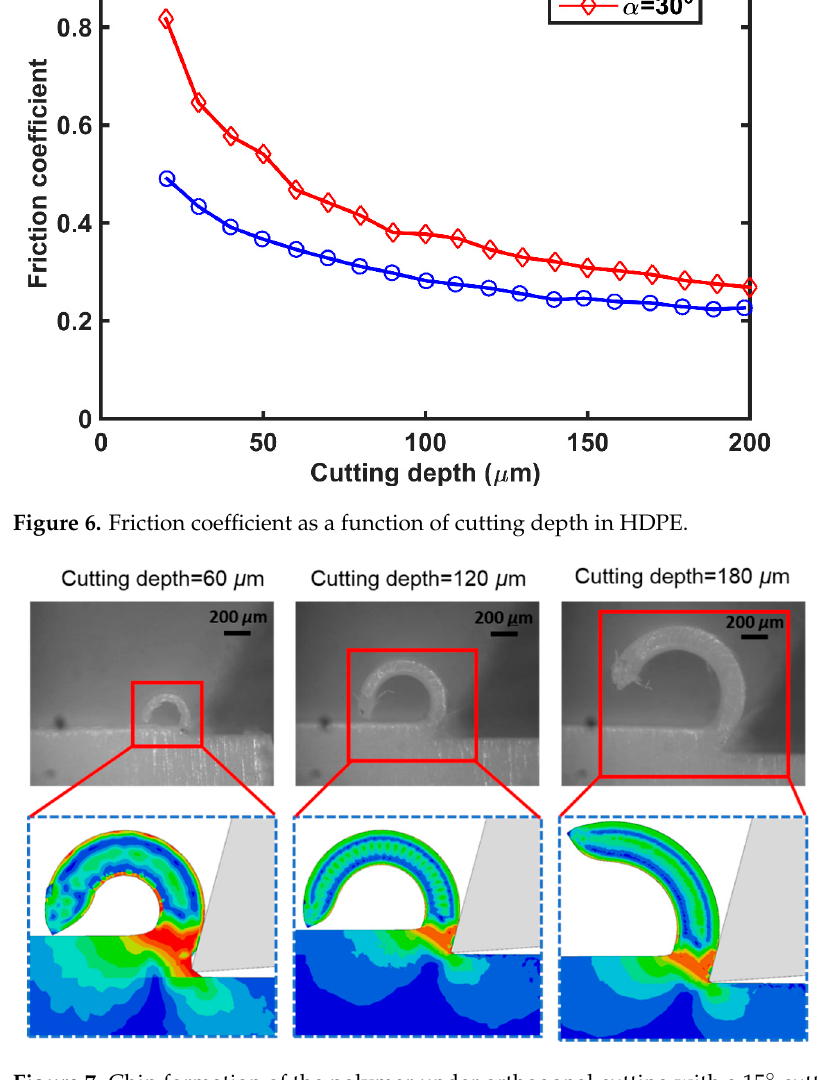
Figure 7. Chip formation of the polymer under orthogonal cutting with a 15° cutting tool.